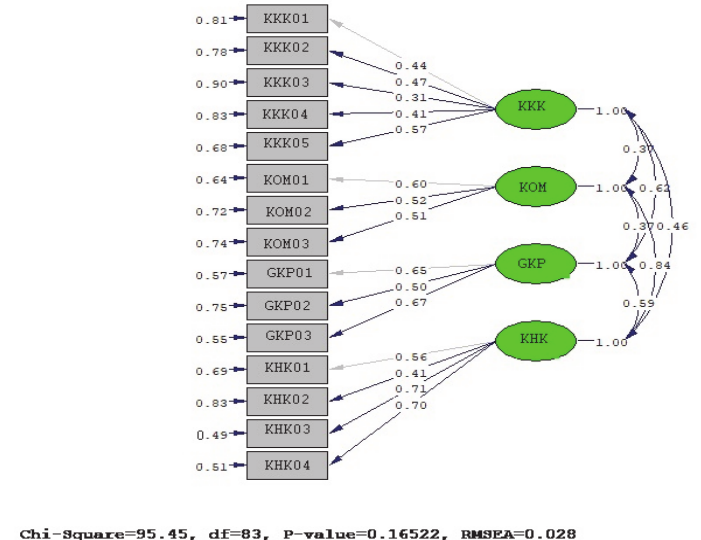
Fig. 1. The proposed